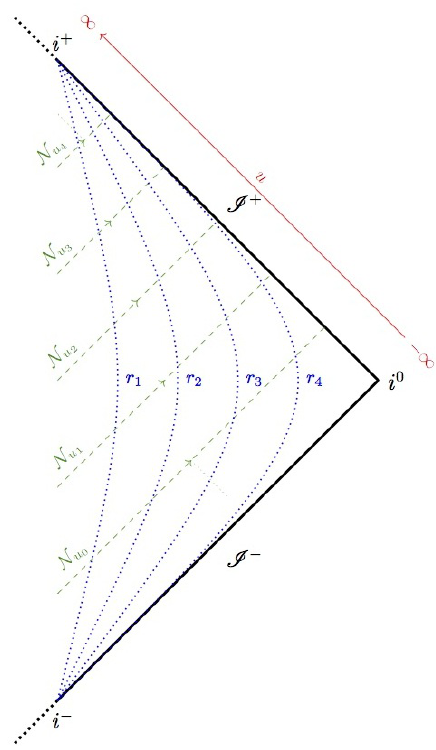
Figure 7 . Penrose diagram indicating hypersurfaces of constant u and r